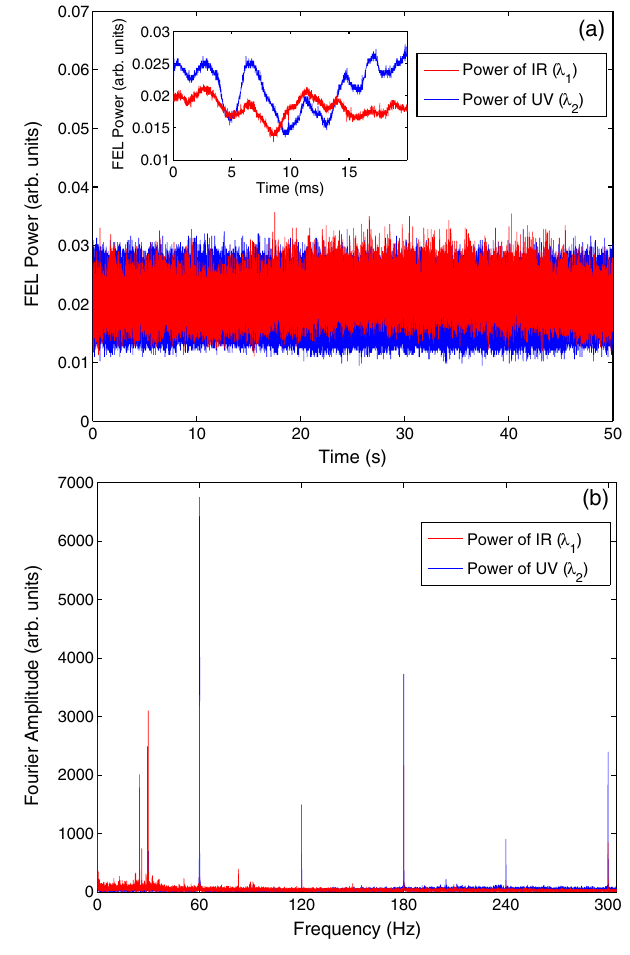
FIG. 14. Longer-term (50 seconds) power data of two-color lasing in the three-undulator configuration (Run 2). (a) Raw power data with a sampling rate of 100 kS = s. The inset is a zoom- in plot showing the details of FEL macropulses. (b) Amplitude of the Fourier transform of the same data plotted for the low- frequency range from 0 to 305 Hz. The rf detune is − 0 . 4 Hz, and the beam current is about 16